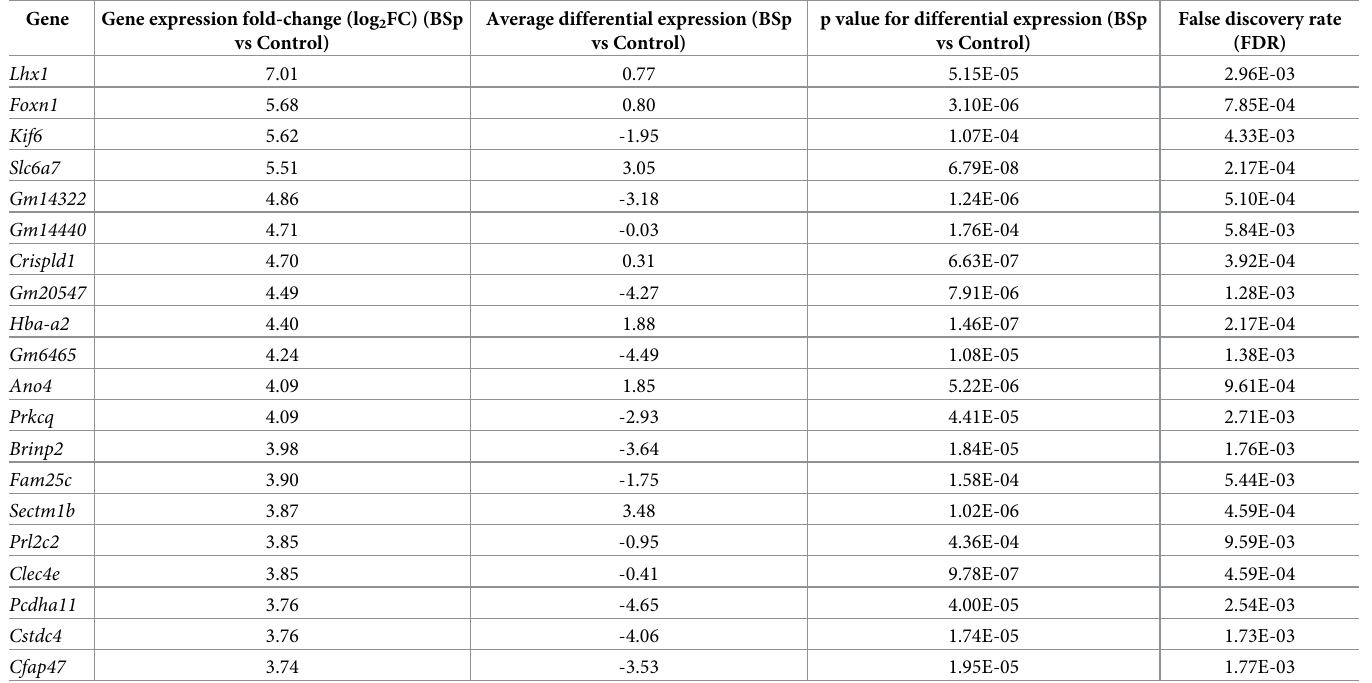
Table 1. Top 20 differentially upregulated target genes in the offspring with the maternal fed BSp diet (ranked by the statistical significance). Gene Gene expression fold-change (log 2 FC) (BSp Average differential expression (BSp p value for differential expression (BSp False discovery rate vs Control) vs Control) vs Control)